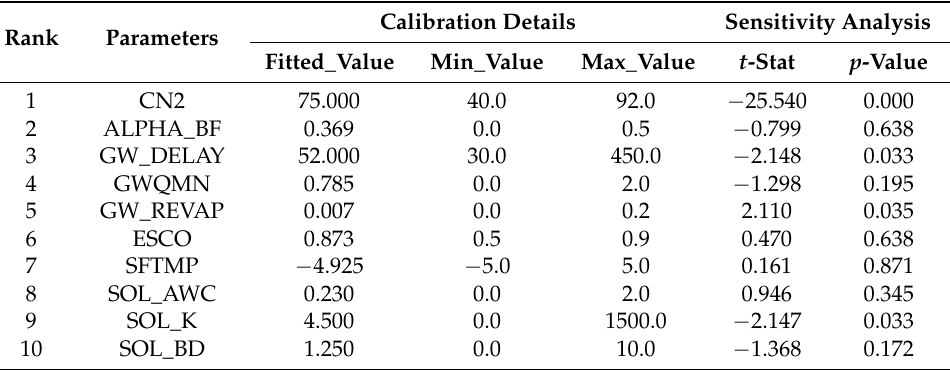
Table 1. Ranking of calibration parameters based on the sensitivity analysis (CN2: runoff curve